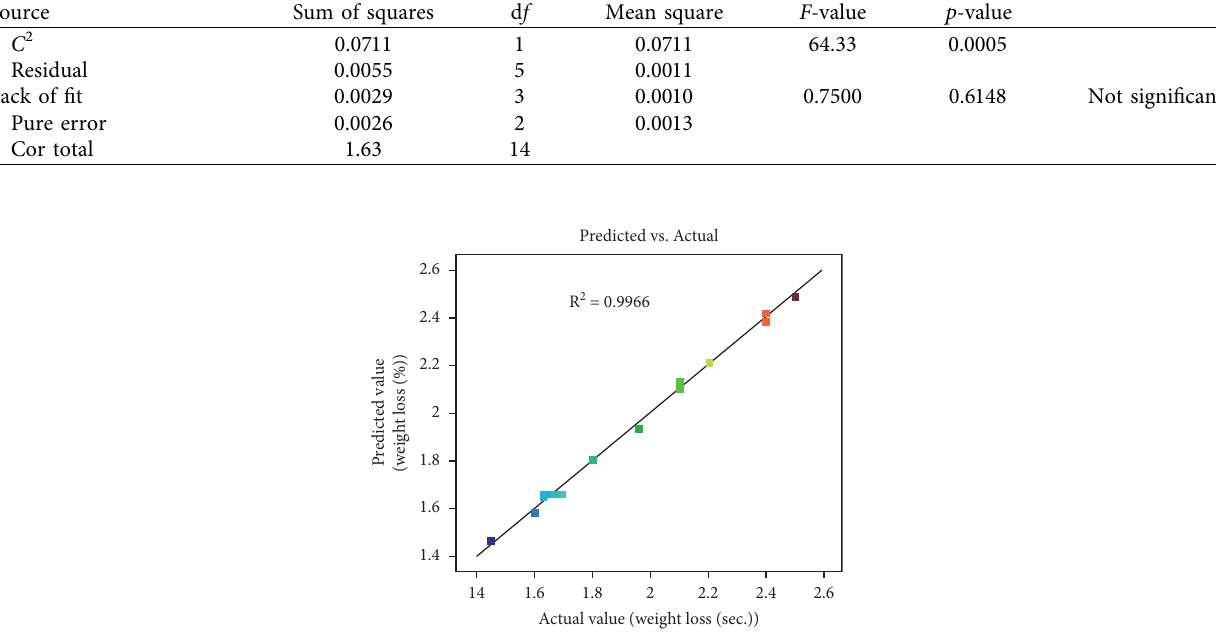
Figure 3: Correlation between the actual value and predicted weight loss.